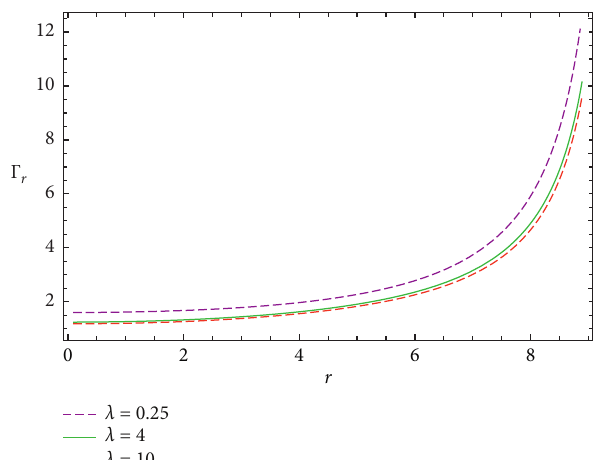
Figure 13: Behavior of Γ against r for Vela X-1 for different values of λ .